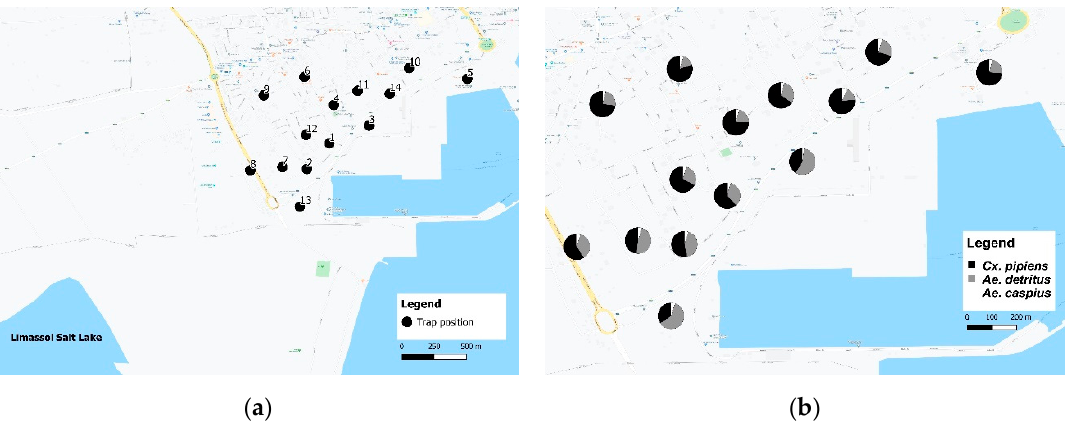
Figure 1. Mosquito trapping sites ( a ) and species composition at each site ( b ).